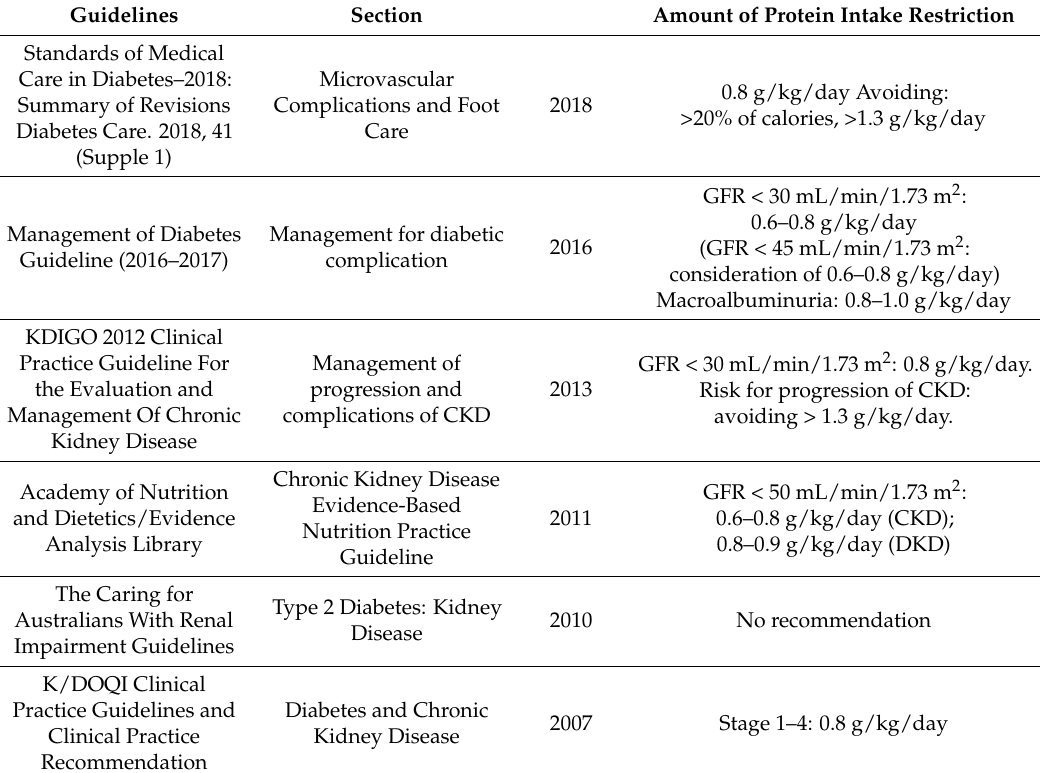
Table 1. Comparison of guidelines for diet therapy, particularly protein intake restriction, for diabetic kidney